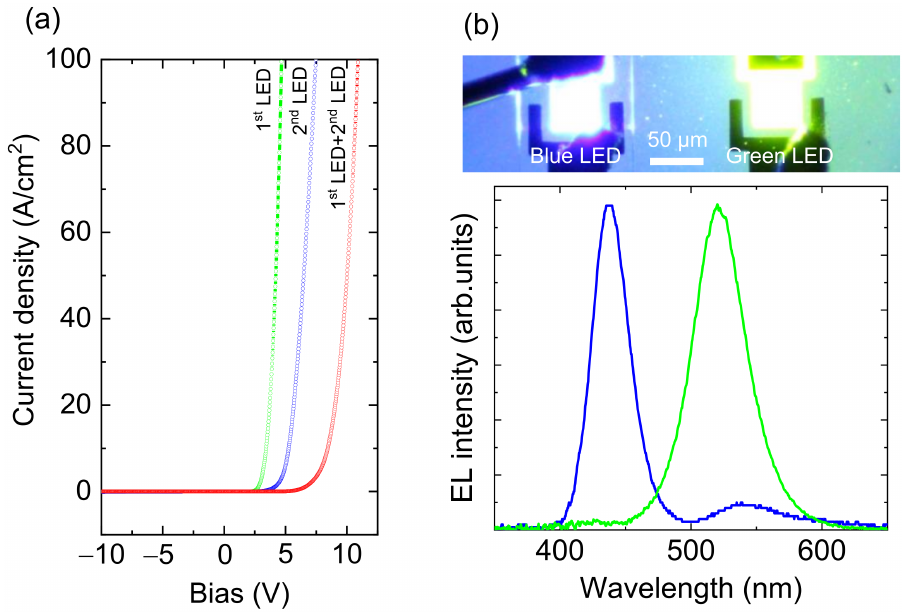
Figure 6. ( a ) Current density–voltage characteristics of the monolithically integrated 1st LED, 2nd LED, and 1st LED +2nd LED, respectively. ( b ) An optical microscope image and EL spectra of the monolithically integrated 1st and 2nd